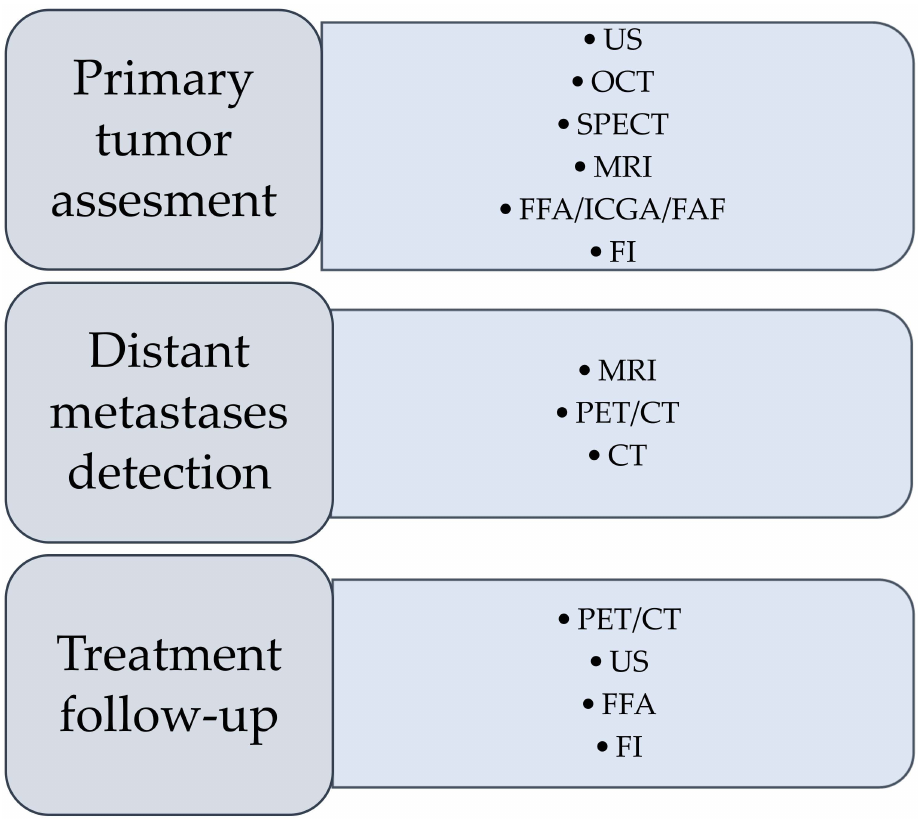
Figure 1. Preferable imaging techniques in different stages of diagnosis and follow-up of uveal melanoma. US—ultrasonography; OCT—optical coherence tomography; SPECT—single-photon emission computed tomography; MRI—magnetic resonance imaging; FFA—fundus fluorescein an- giography; ICGA—indocyanine green angiography; FAF—fundus autofluorescence; PET—positron emission tomography; CT—computed